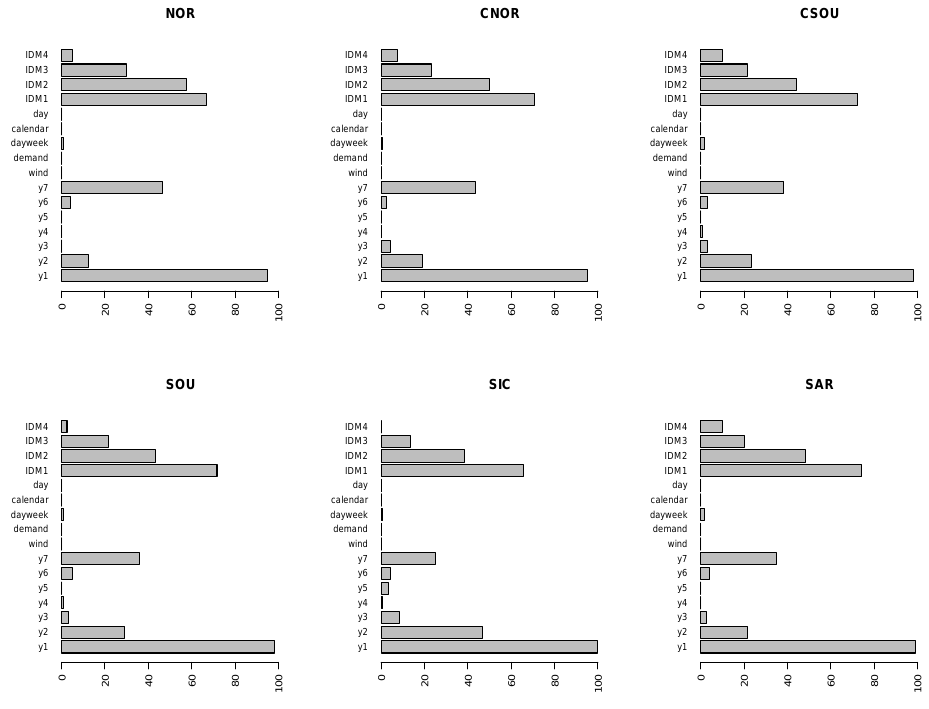
Figure 5. Variable importance measures for the RF. Weighted percentage of times the variables are within the fifth position out of 24 h. y 1, . . ., y 7, are labels of lagged variables y t − 1 , . . . , y t − 7 , respectively. The bars represent the weighted percentage of times the variables are within the fifth position out of the 24 h. To evaluate correctly the results, we have to consider that prices for the last two sessions of the IDM are not available for all the 24 h, so for IDM3 and IDM4 the bars refer to the weighted percentage out the 12 and 8 h,